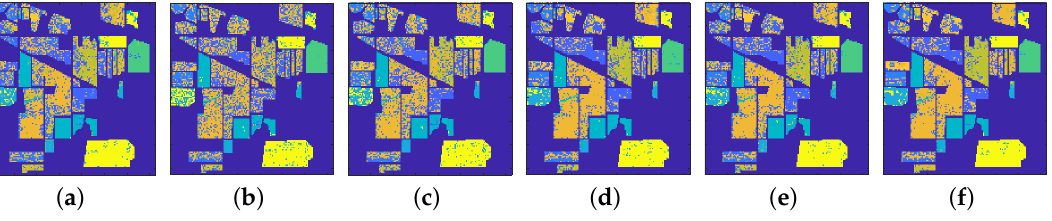
Figure 6. KNN classification maps of using the fifteen bands selected by different methods from the Indian Pine dataset. ( a ) MVPCA ( b ) LCMVBCC ( c ) LCMVBCM ( d ) ECA ( e ) OPBS ( f )